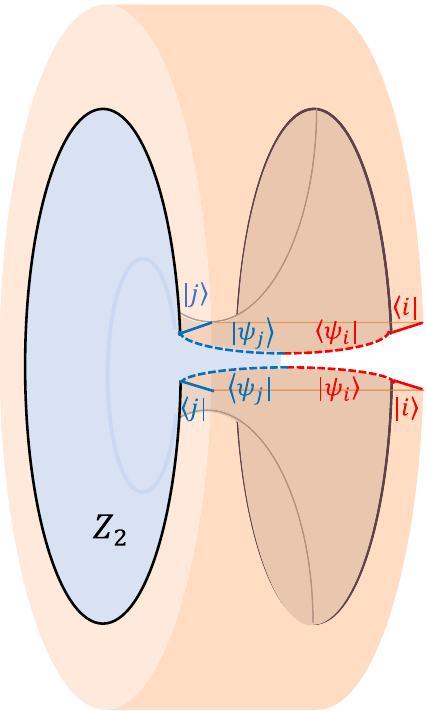
Fig. 1 Replica wormhole saddle in calculating the purity of radiation (6). The picture is a diagrammatic representation of (cid:7) (cid:3) (cid:4) ,ψ | ψ ,ψ ψ .Thereisawormholegeometry,andthefinalresult i j i j (cid:3) (cid:4) (cid:7) i , j ,ψ | ψ ,ψ ψ = k 2 Z is i j i j 2 . Note that the * symbol representing i , j the CPT transformation is not explicitly shown in the figure